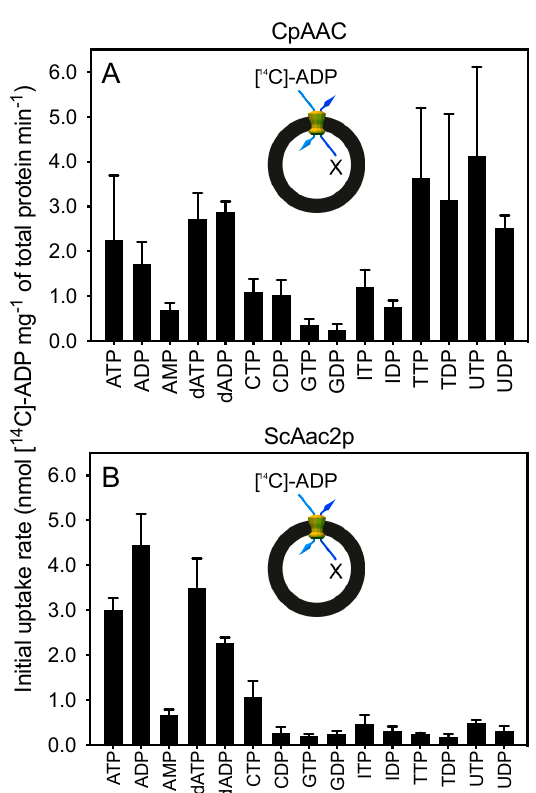
Figure 7. CpAAC has a broader substrate specificity than the yeast ADP/ATP carrier ScAac2p . Fused lactococcal membranes expressing ( A ) CpAAC or ( B ) ScAac2p were loaded with 2.5 mM of the indicated substrate (X), and hetero-exchange was initiated by the addition of 1.5 μ M [ 14 C]-ADP on the outside (see insets). The initial specific transport rates were determined over the linear part of the uptake curve, typically in the first 60 s. Data are represented by the mean and standard deviation of initial hetero-exchange rates of two biological repeats with six technical repeats in total.